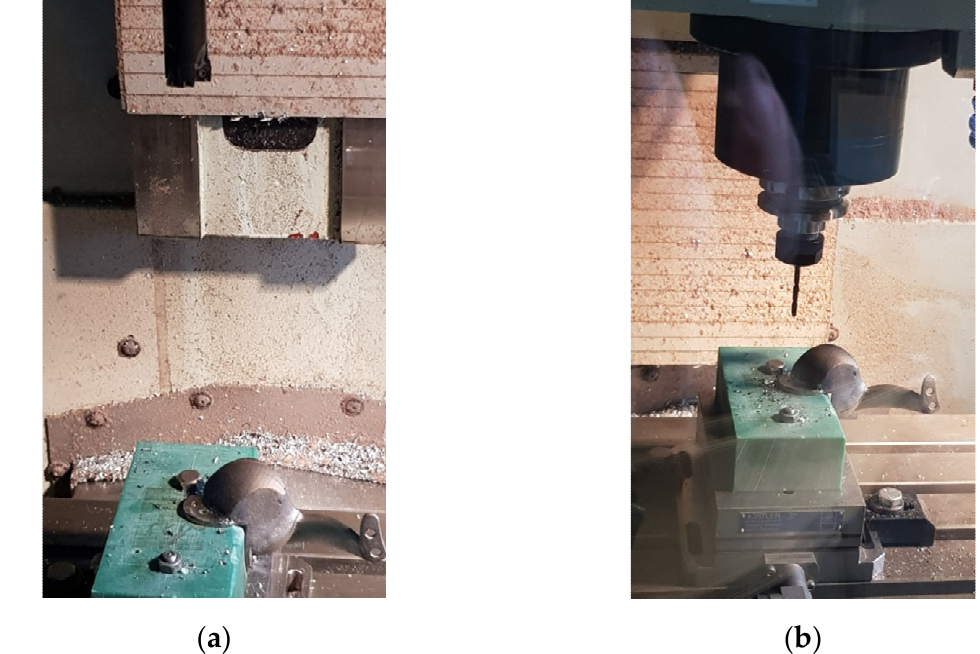
Figure 8. Cutting machining for the dimensional restoration of the personalized implant: ( a ) fixing the implant in the device to mill the edges of the implant; ( b ) drilling holes.